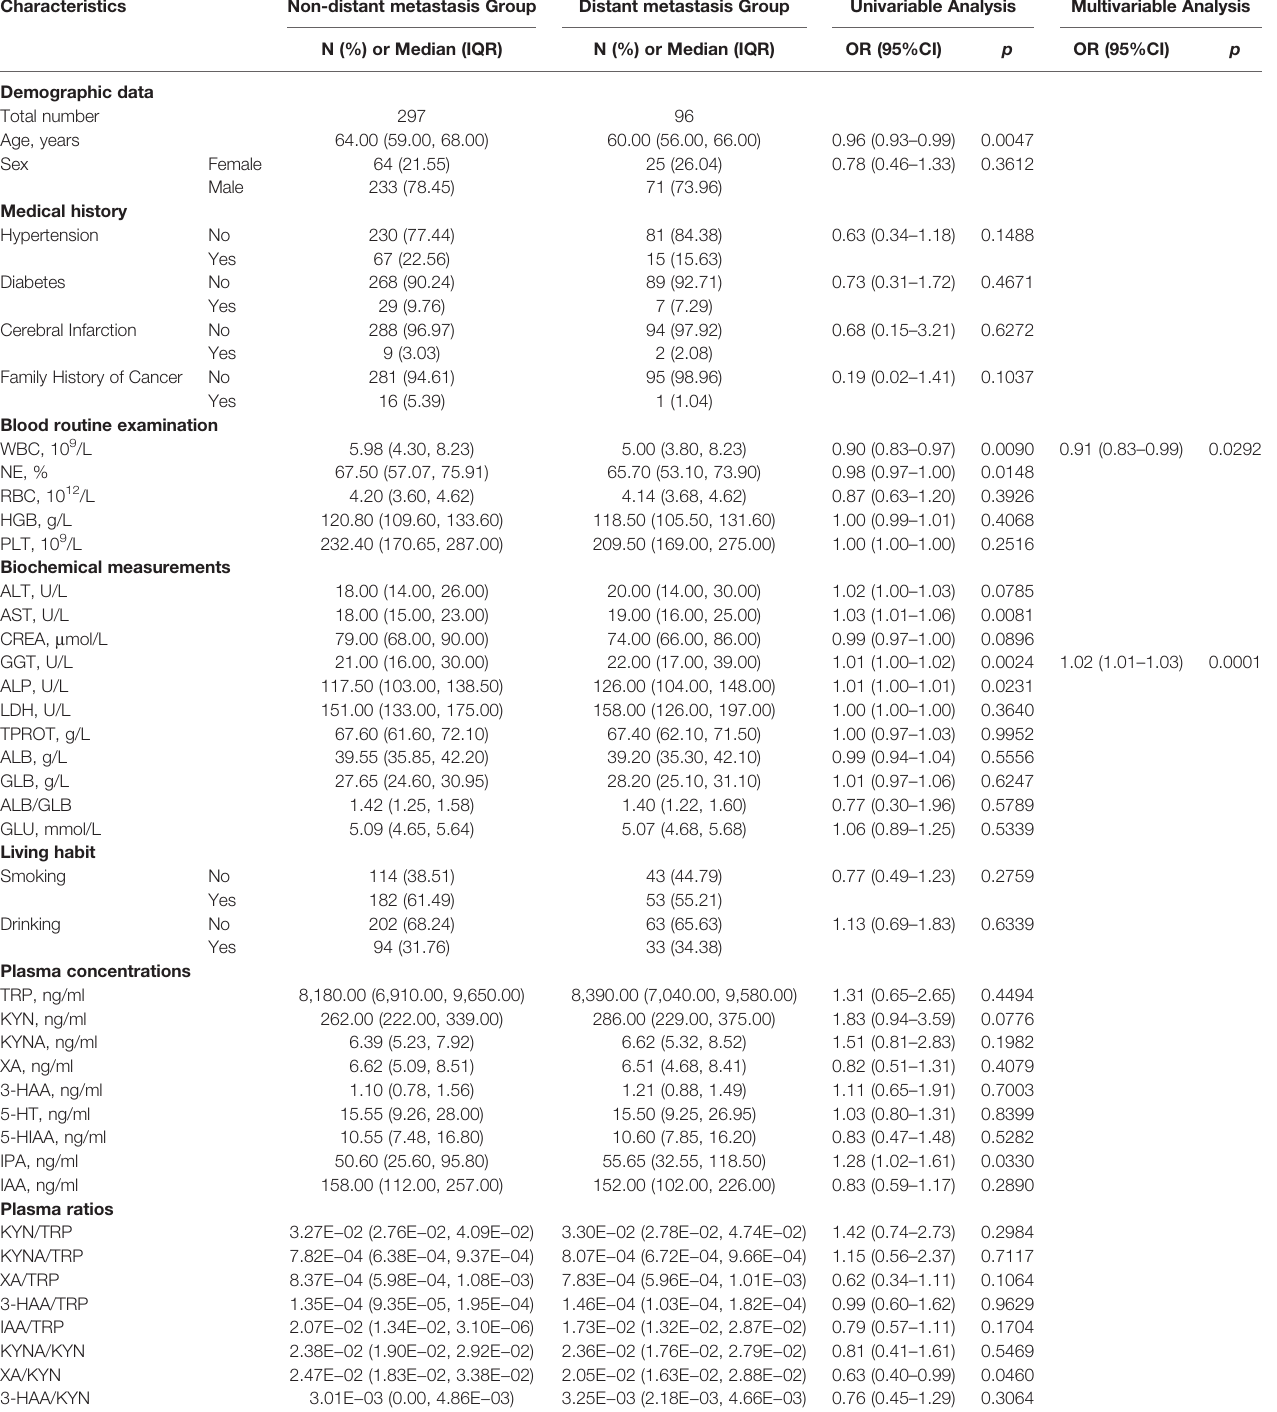
TABLE 3 | Associations of metabolites and baseline data with distant metastasis